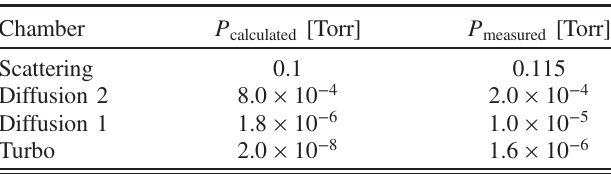
TABLE II. Calculated vs measured pressures (for air). All values are given in